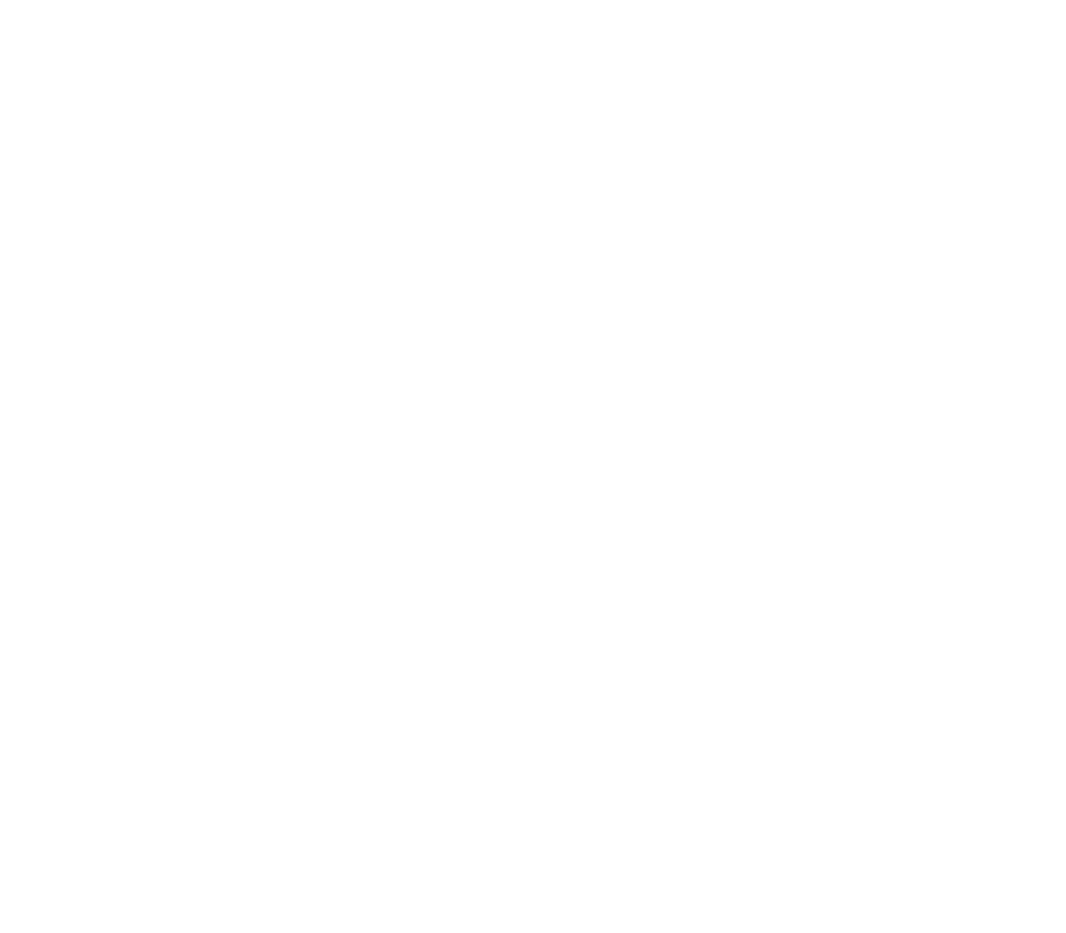
Figure 13. ( a , c ) the cross-section spectra of the nanorod with the coupled structure on a substrate. ( b , d ) the cross-section spectra of the tapered nanoantenna with the coupled structure on a